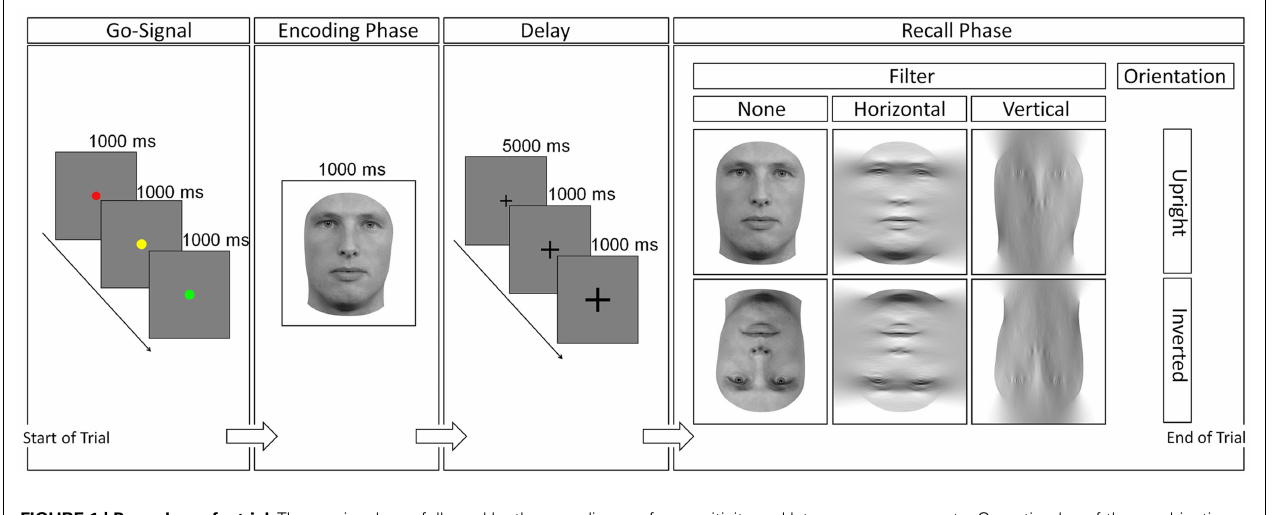
FIGURE 1 | Procedure of a trial. The go-signal was followed by the encoding phase, a fixation cross accompanying a short delay, and finally the recall-phase. Response was given at the last stage and served as measures